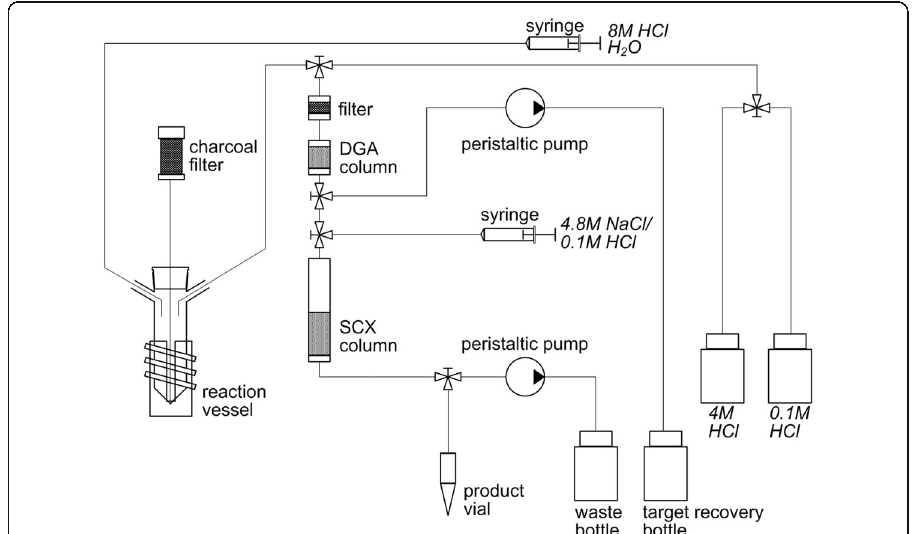
Fig. 2 Schematic diagram of the 46 Ti/ 43 Sc separation